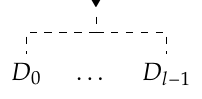
Figure 5. Initial inference.